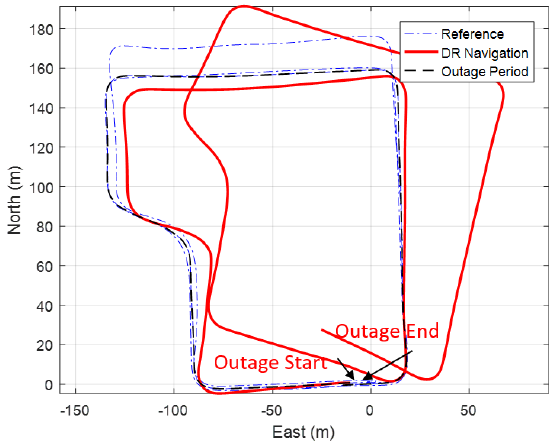
Figure 13. DR trajectory for 180 seconds GNSS signal outage